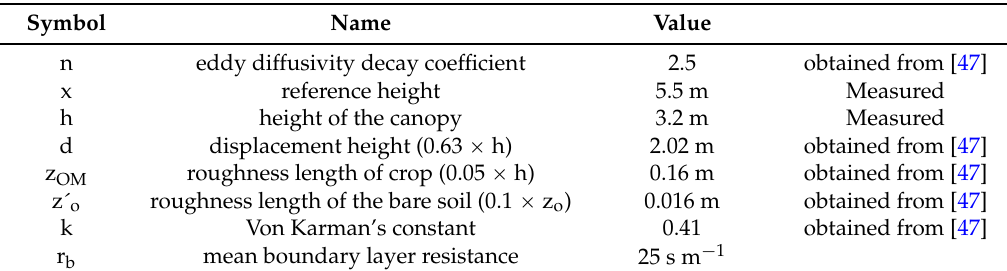
Table A1. List of constants used in the aerodynamic